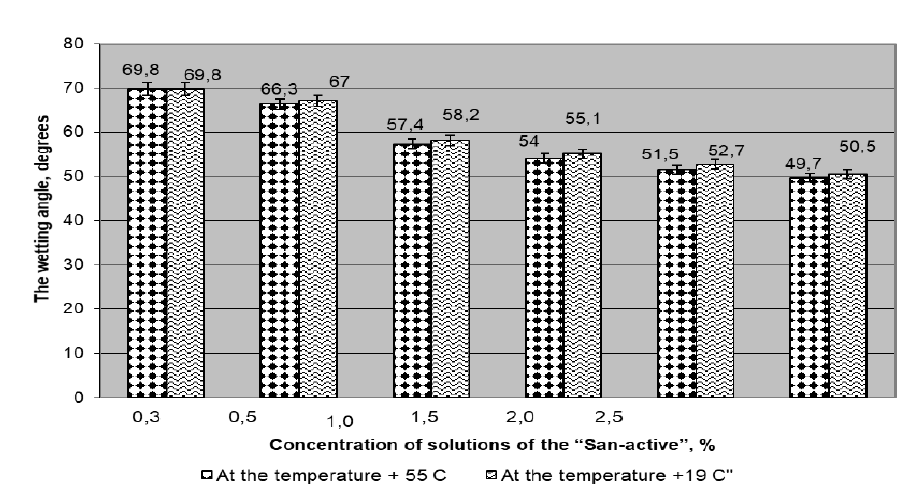
Fig. 3. The wetting ability of solutions of the “San-active” depending on its